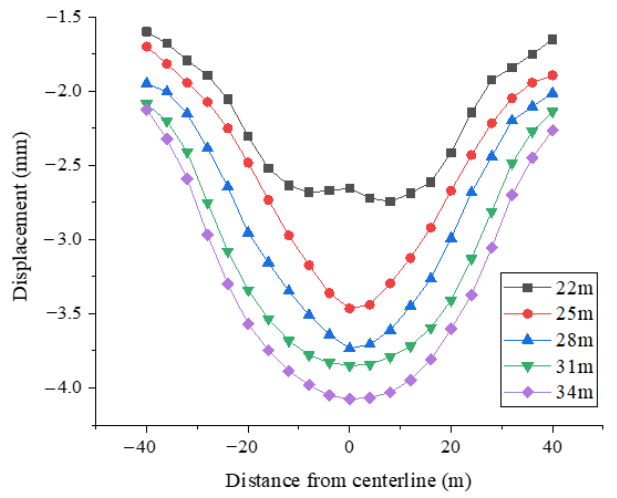
Figure 11. Lateral variation curve of ground settlement for different tunnel depths at 10 m depth in excavation direction.